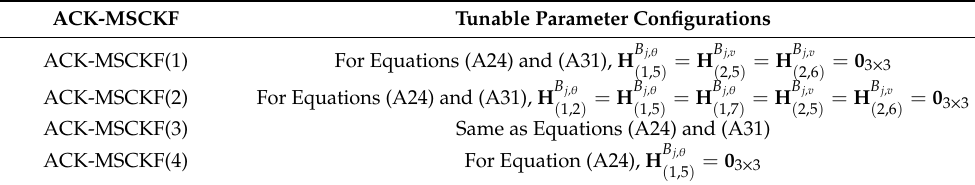
Table 1. The tunable parameter configurations of